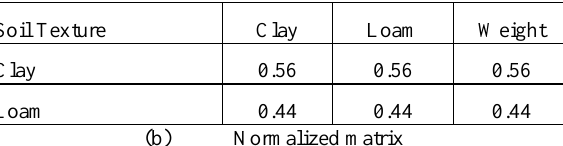
Table 4. Deriving the relative weights of the soil texture parameter